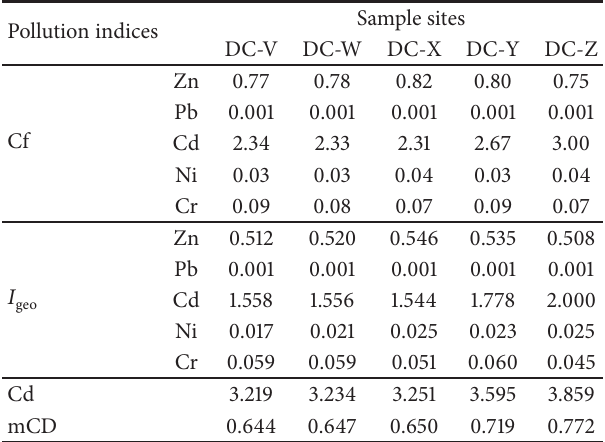
Table 3: Pollution indicators for trace metals in sandflats from Douglas Creek.